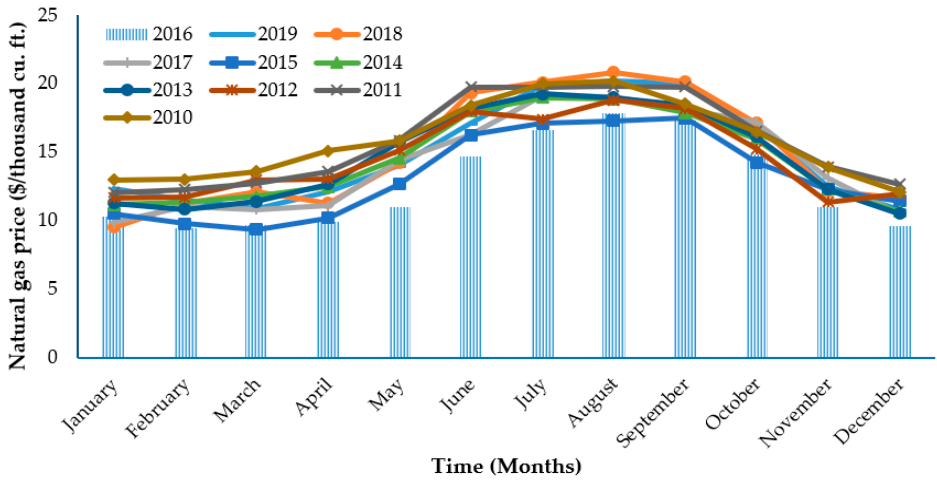
Figure 9. Trends in natural gas price variation.